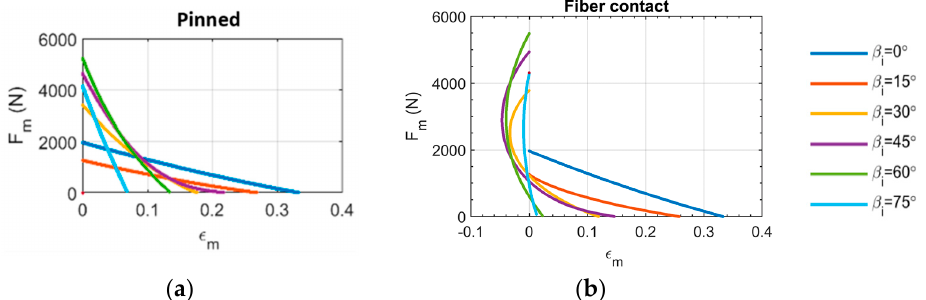
Figure 5. Muscle force–muscle strain behavior of parallel ( β i = 0 ◦ ) and bipennate muscle bundles with pinned boundary condition ( a ) and fiber contact boundary condition ( b ). The legend shown on the far right indicates the fiber pennation angle of the muscle topology.